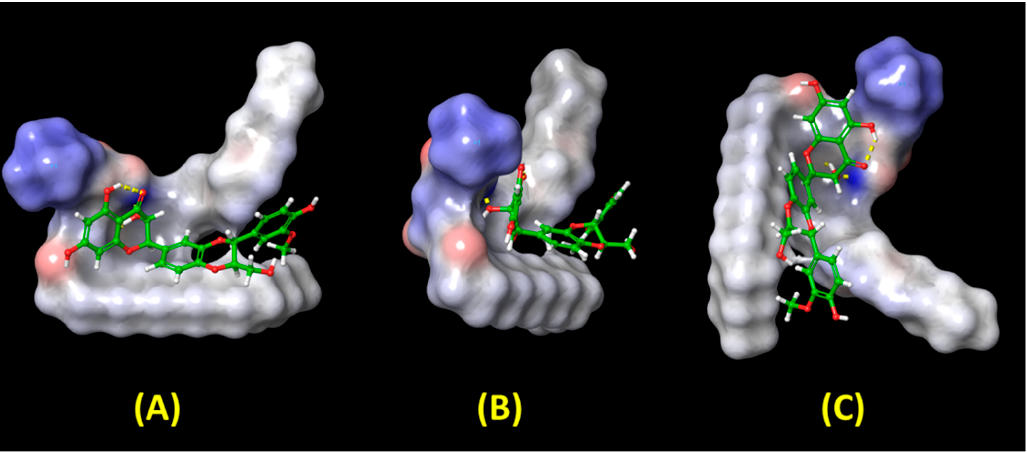
Figure 9. Illustration of the binding poses of SIL and SPC on forming complexes in three different orientations, ( A – C ). Table 5. ‘ ∆ G bind’ energy for the SIL–SPC complex, determined by Prime MM-GBSA calculations for molecular docking and MD